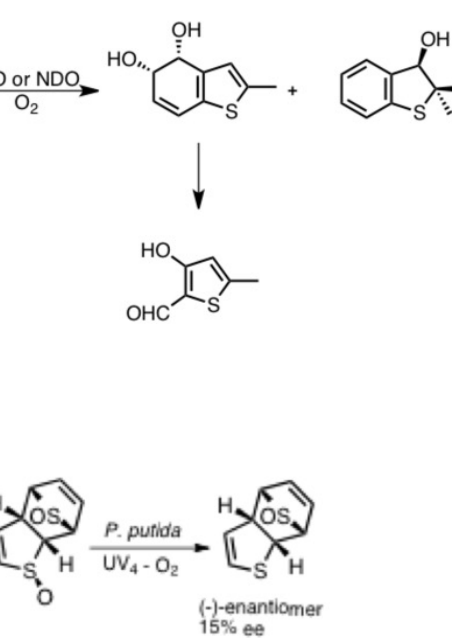
Figure 25 - Thiophene over oxygenation and formation of